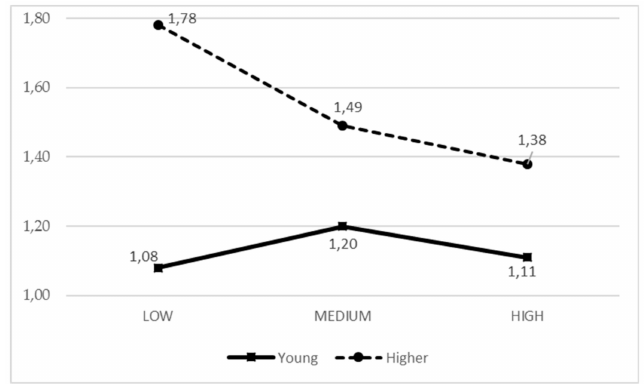
Figure 4. Means of the IPAF3 parental style based on the adolescent age for alcohol